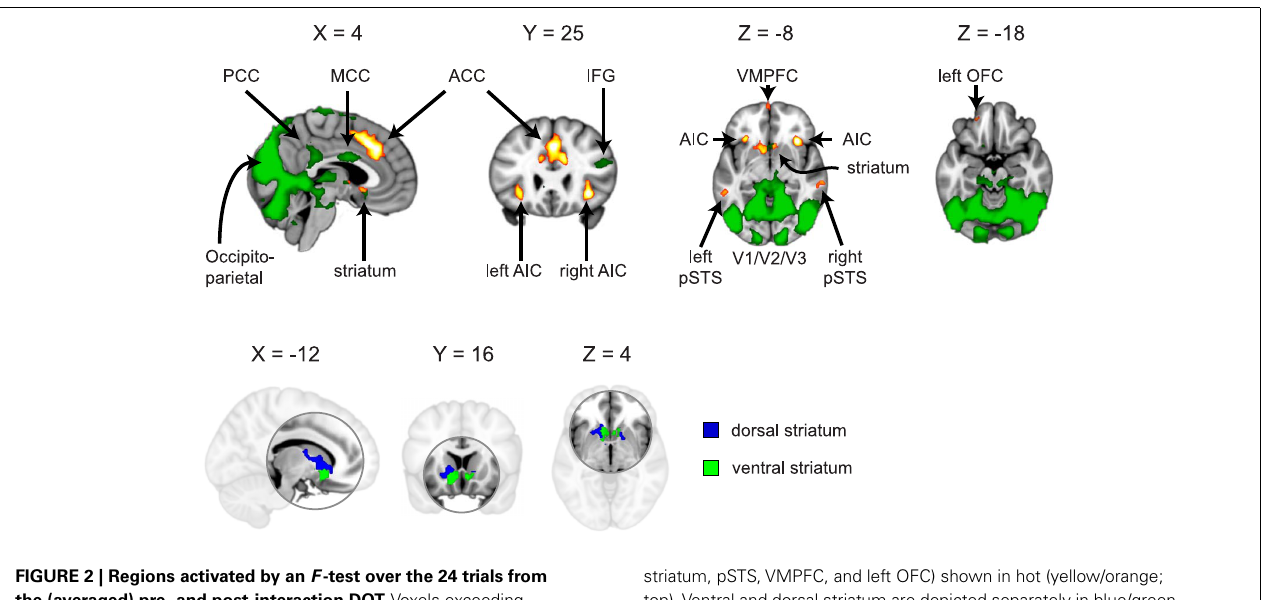
FIGURE 2 | Regions activated by an F -test over the 24 trials from the (averaged) pre- and post-interaction DOT. Voxels exceeding Z = 3.1 ( p < 0.001, uncorrected) in clusters larger than 40 voxels are shown in green, with selected regions of interest (AIC, ACC,